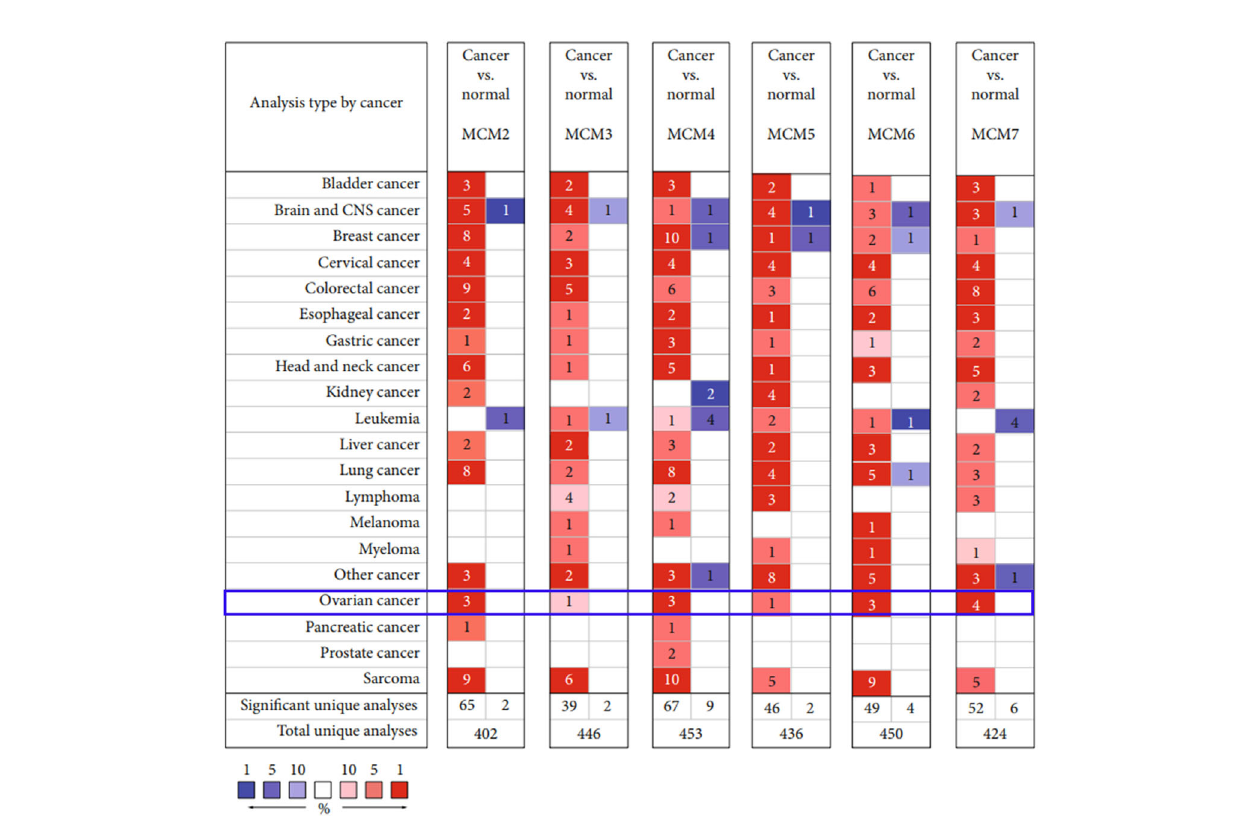
FIGURE 2 | Transcriptional level of MCM complex members in 20 cancer types. The levels of the MCMs in different cancer types. The threshold (P value ≤ 0.05; ∣ FDR ∣ ≥ 2; gene rank ≤ 10%; data type: mRNA) is expressed in colored cells. Red indicates that the gene is increased in cancer tissues compared to that in normal tissues, whereas blue indicates that the gene is downregulated in cancer tissues compared to that in normal tissues. The FDR is presented by color